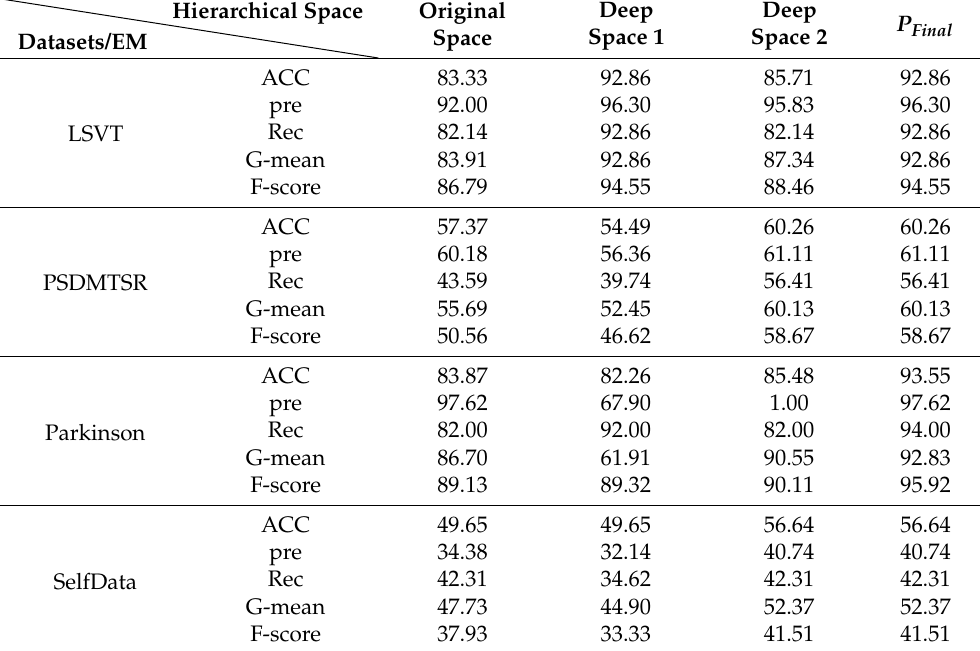
Table 6. Verification of the integration output